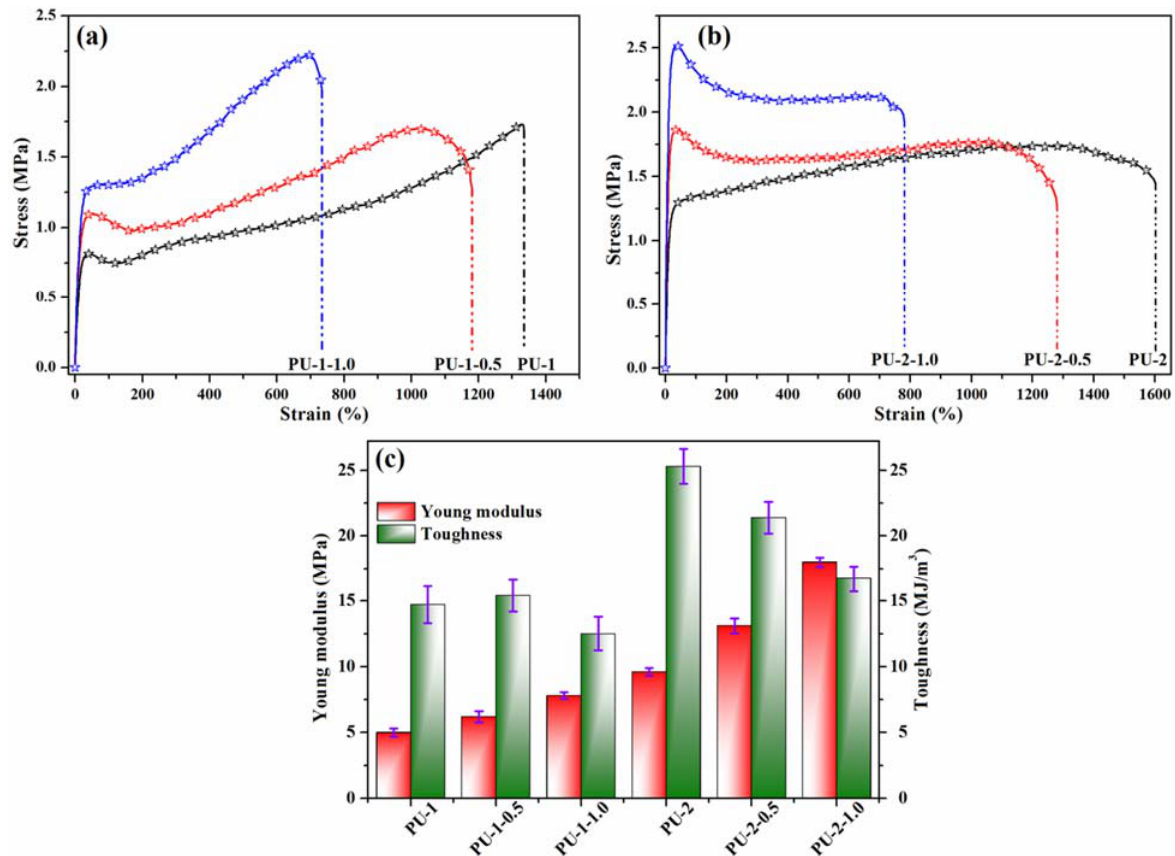
Figure 7. Representative stress–strain curves for polyurethanes and composite specimens ( a , b ) and the statistical results of the Young modulus and toughness measurements ( c ).